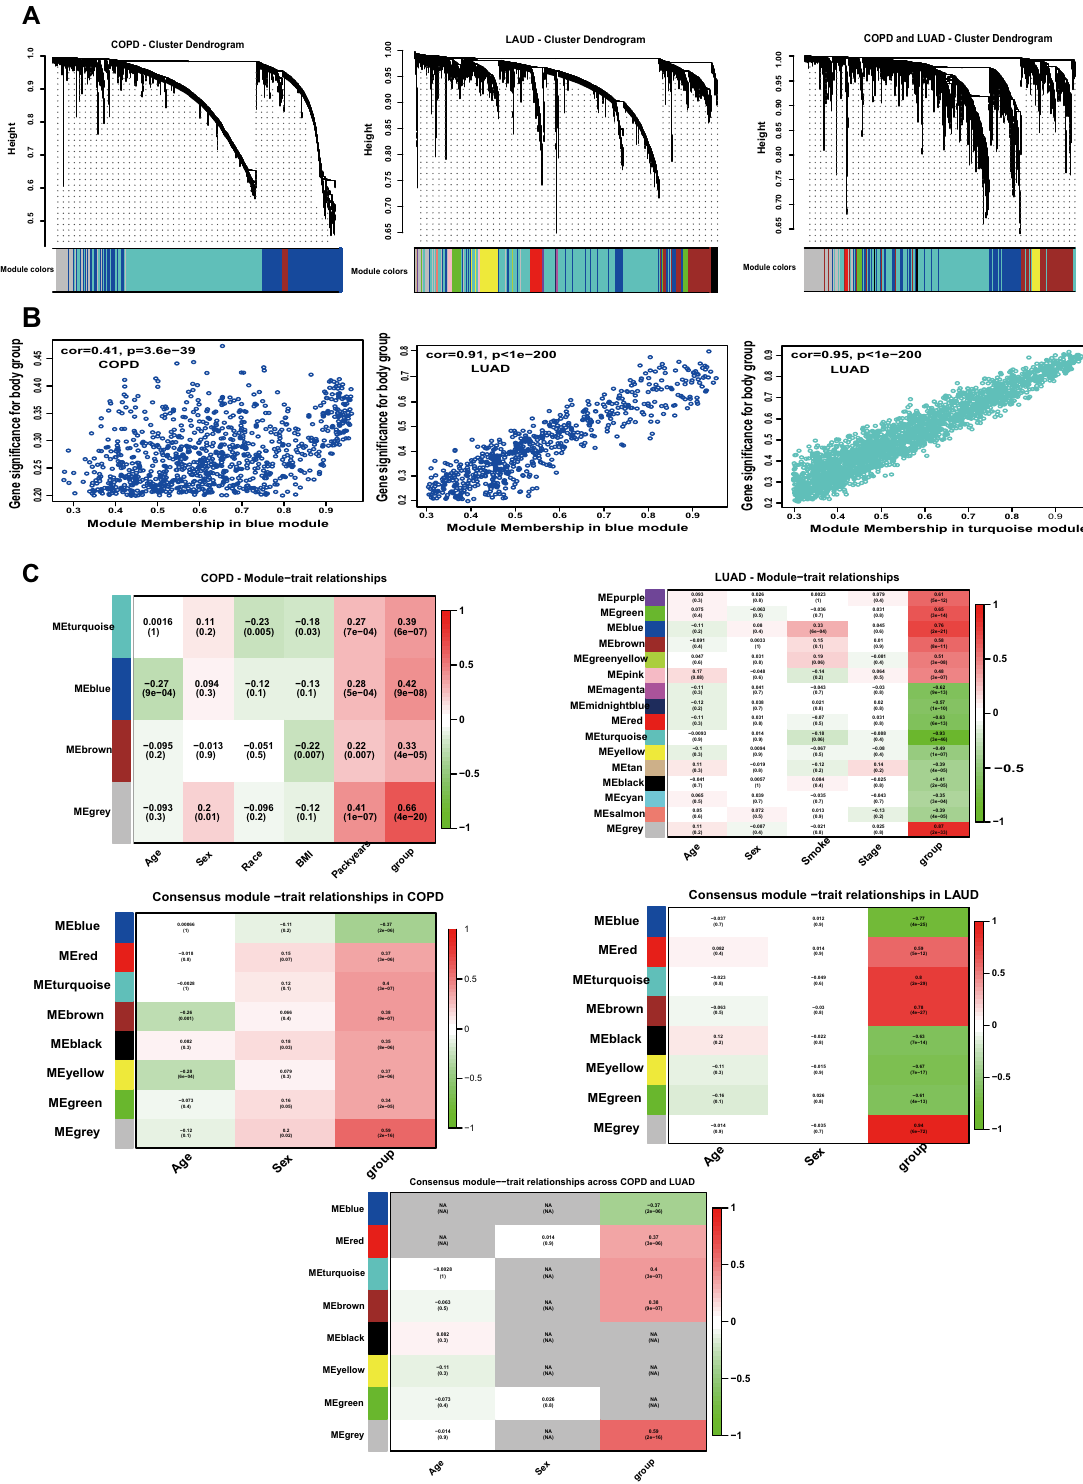
Figure 3. ( A ), the clustering dendrogram of genes. Disease-specific candidate genes with the same functions are denoted by the same color. Gray color denotes genes with unknown function. ( B ), Scatter plot between genes and diseases in important modules. ( C ), Heatmap of module–trait relationships between module genes and clinical traits. In the consensus module, If the two diseases presented similarly in the same clinical trait, the same color was applied to both modules; if the presentation of the diseases was different, then the module was colored gray. COPD: chronic obstructive pulmonary disease; LUAD: lung